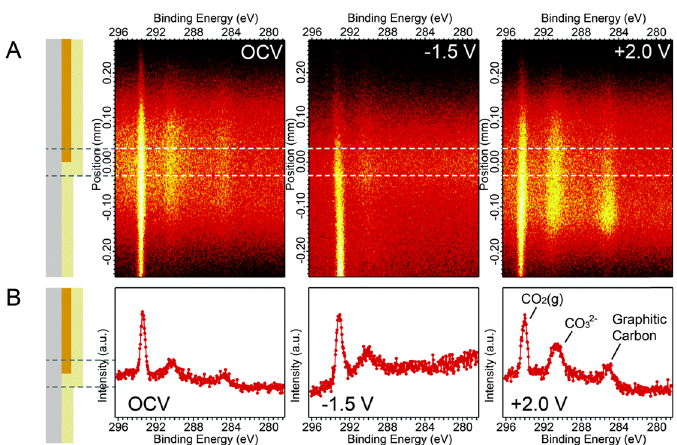
Figure 9. ( A ) Spatially-resolved NAP-XPS measurements of the C 1s obtained with a two-dimensional area detector at 0, − 1.5 and + 2.0 V applied potentials with 490 eV photon energy. A corresponding schematic cell drawing is given on the left. ( B ) Integrated XPS spectra obtained by slicing a 60 µ m-wide segment from the corresponding photoelectron signal in ( A ) at a position of 0.0 mm. Intensities are normalised to the CO 2 gas-phase peak. Reprinted with permission from [303], copyright 2014, Royal Society of Chemistry.